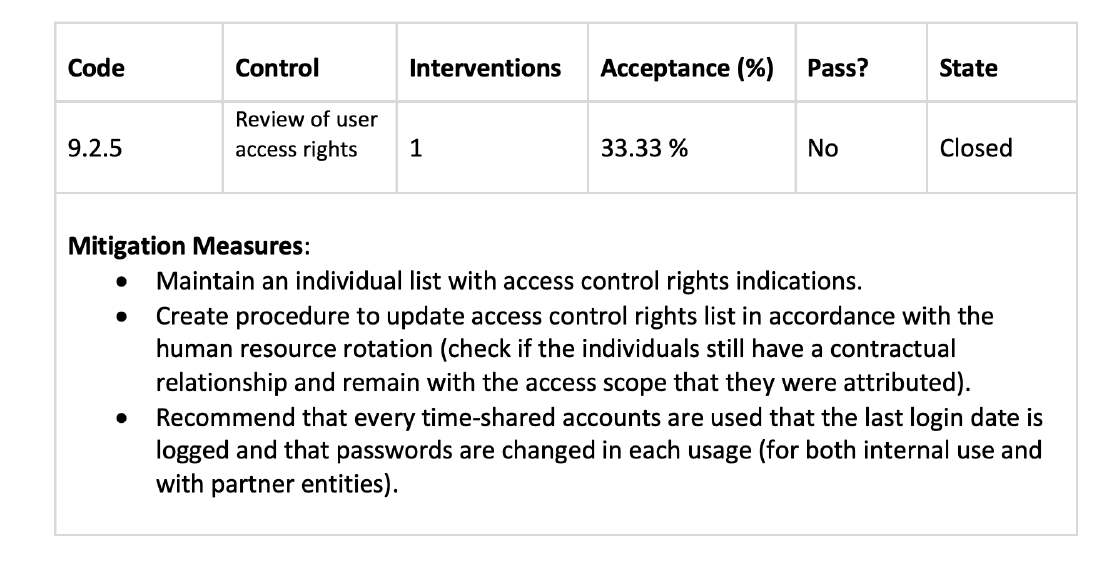
Figure 9. Example of the report generated for Control